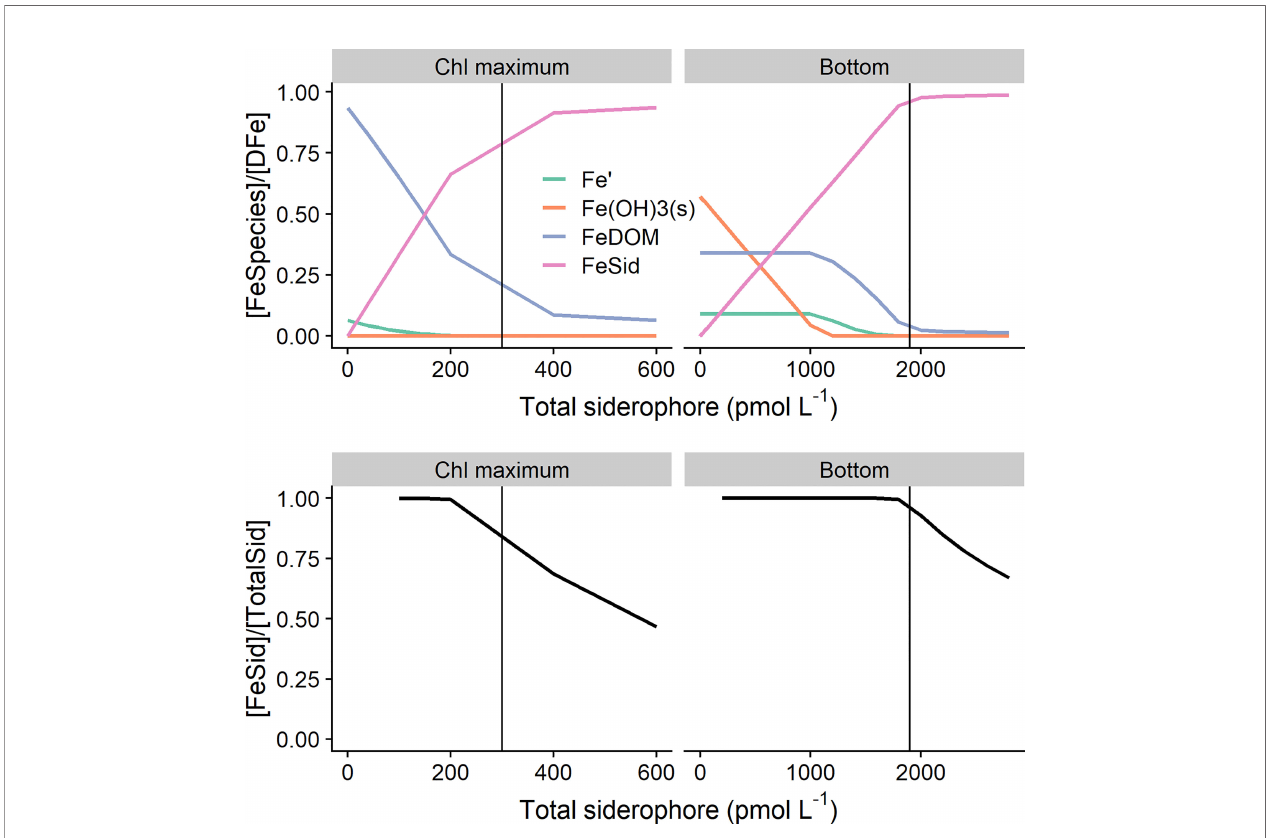
FIGURE 6 | Calculated species distributions for 0.3 (left panels) and 1.9 nmol L -1 (right panels) iron concentration expressed as the concentration of the species ([FeSpecies]) divided by the concentration of iron ([Fe]). Iron concentrations (pmol L -1 ) are indicated by the vertical black line and were representative of dissolved iron concentrations observed in the chlorophyll maximum (Chl maximum) and close to the sediment (Bottom) respectively. Top panels show the abundance of inorganic Fe (Fe´), Fe bound to dissolved organic matter (FeDOM), Fe bound to siderophores (FeSid) and Fe present as (Fe(OH) 3 (s) relative to the total iron concentration as a function of increasing total siderophore concentration. Bottom panels show the proportion of iron bound to siderophores relative to the total siderophore concentration as a function of increasing total siderophore